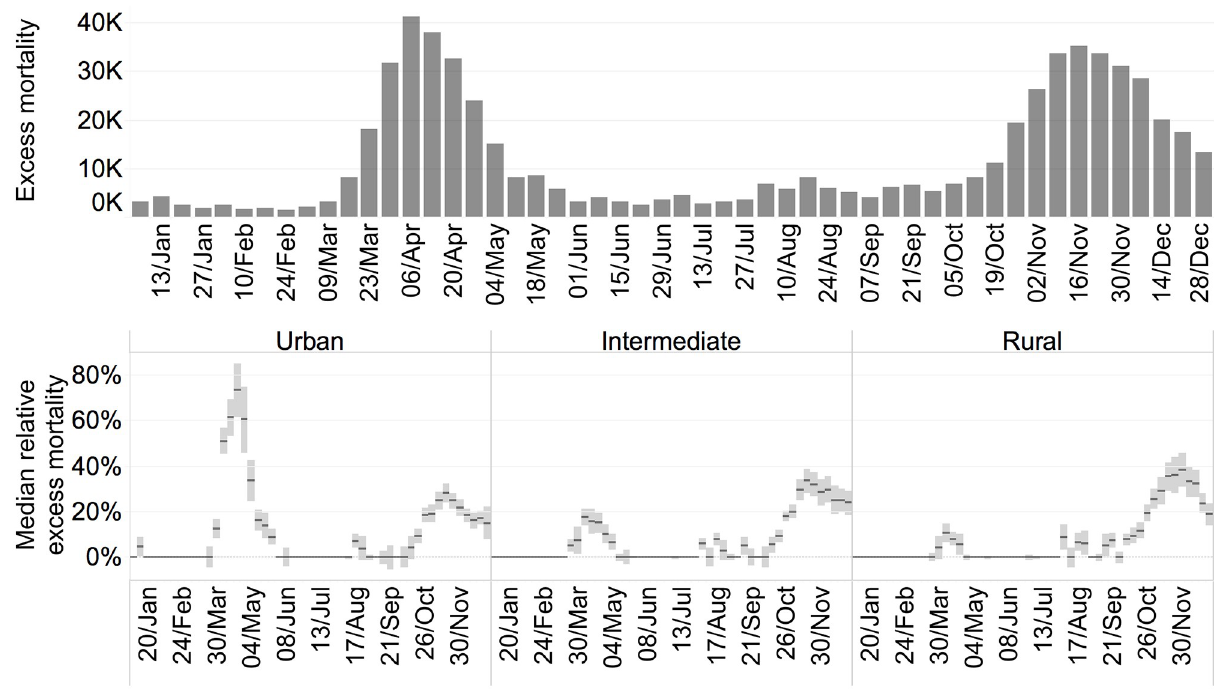
Fig 3. Total excess mortality (upper panel) and median relative excess mortality with 95% CI by rural-urban typology (lower panel) on a weekly basis.